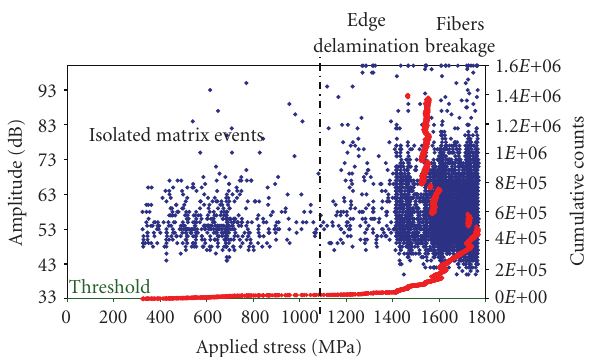
Figure 7: Typical acoustic behavior under tensile load of a sample with integrated